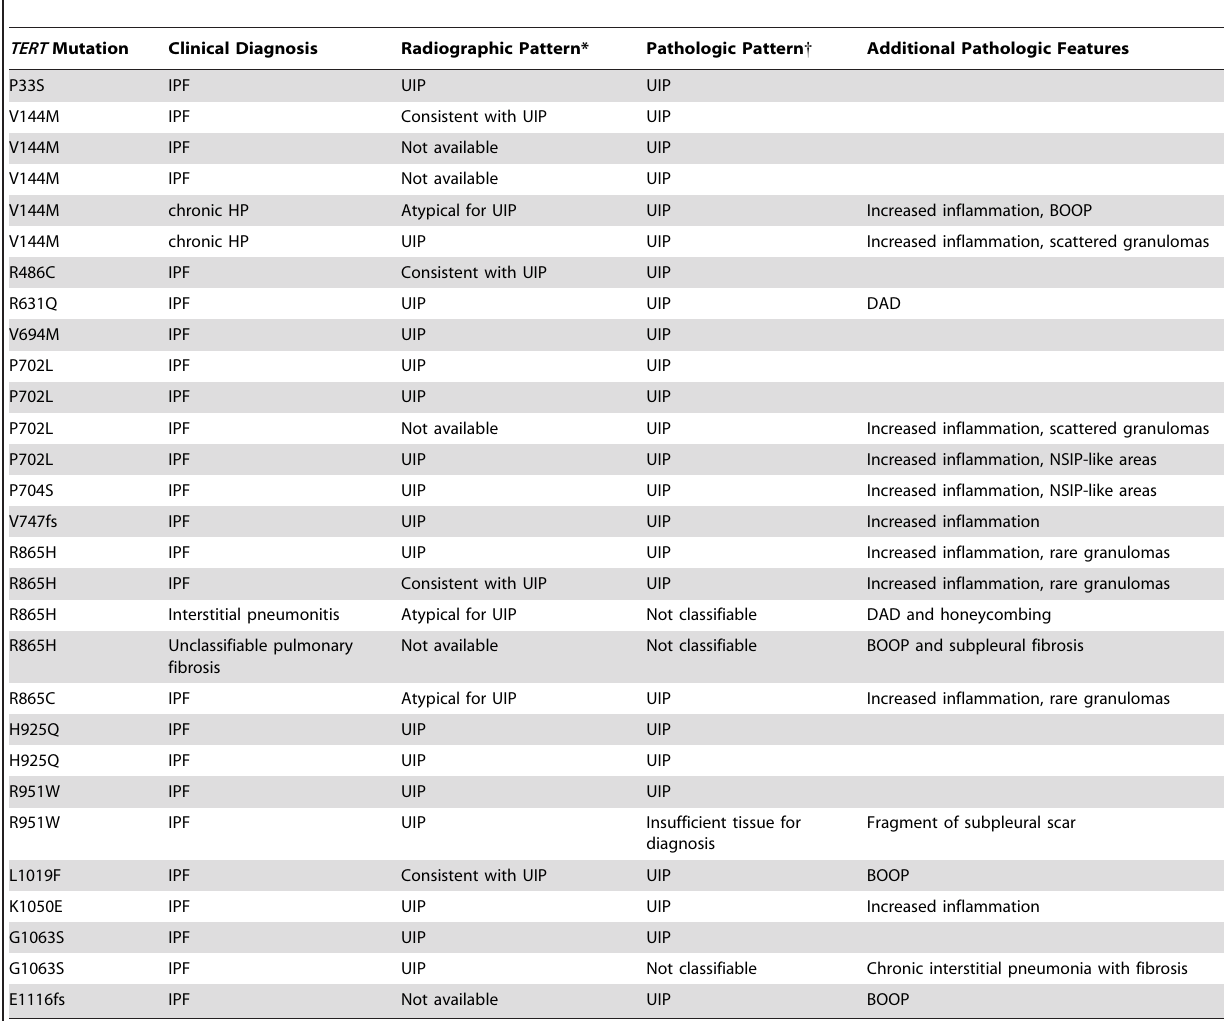
Table 5. Clinical diagnosis, radiographic pattern and pathologic features of 29 TERT mutation carriers with surgical lung